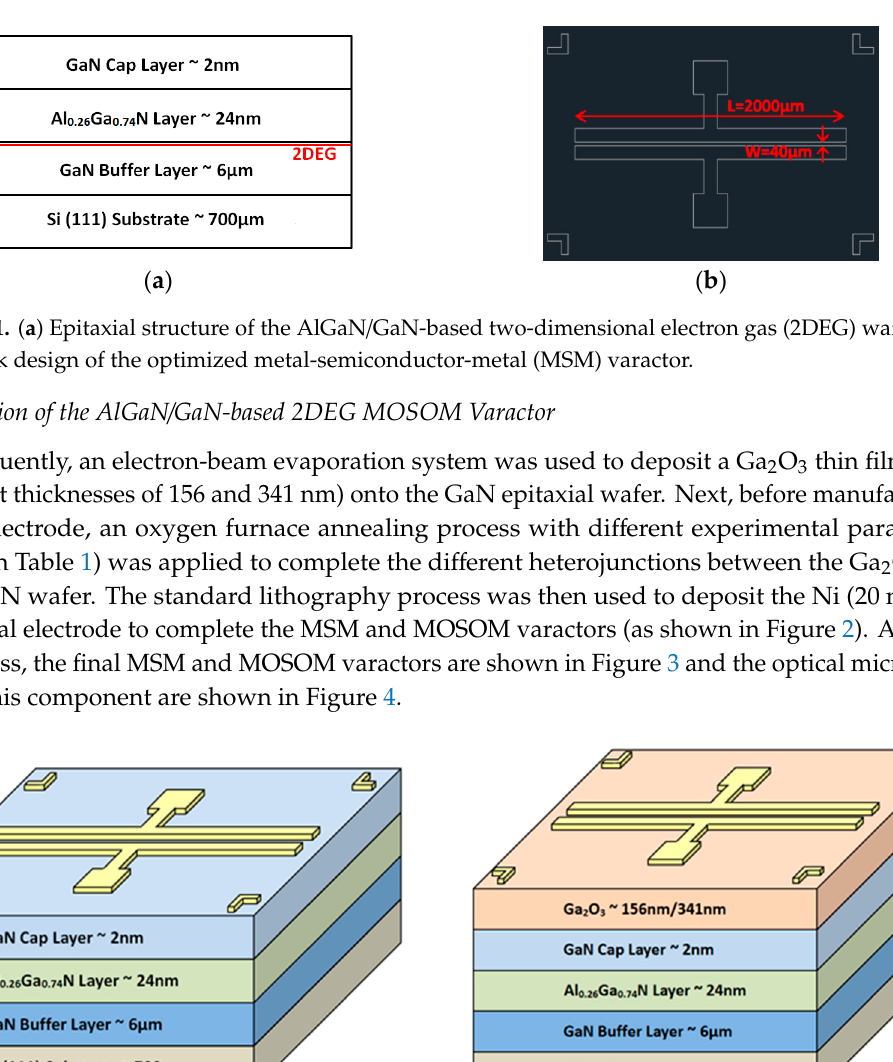
Figure 2. 3D structure of the MSM and metal-oxide-semiconductor-oxide-metal (MOSOM) varactors.